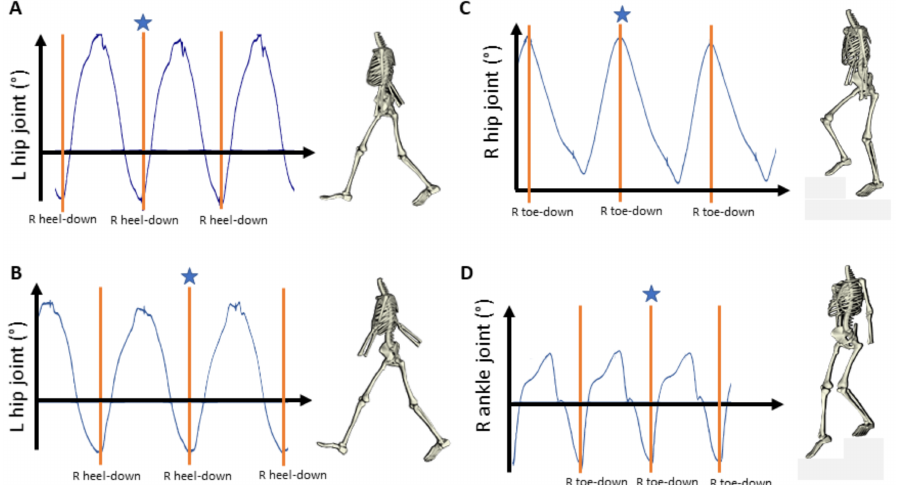
Figure 2. Example of the event settings for one of the study participants. Joint curves and skeletons are printed from the MoLab TM analysis software. Image adjustments, such as adding vertical orange lines, gray shaded stairs, and axis legends, were done for graphical reasons only. The joint curve used for each event setting is shown for comfortable gait ( A ), fast gait ( B ), stair ascending ( C ), and stair descending ( D ), together with the animated segment model. The star marks the event at the time frame for which the segment model for the participant is